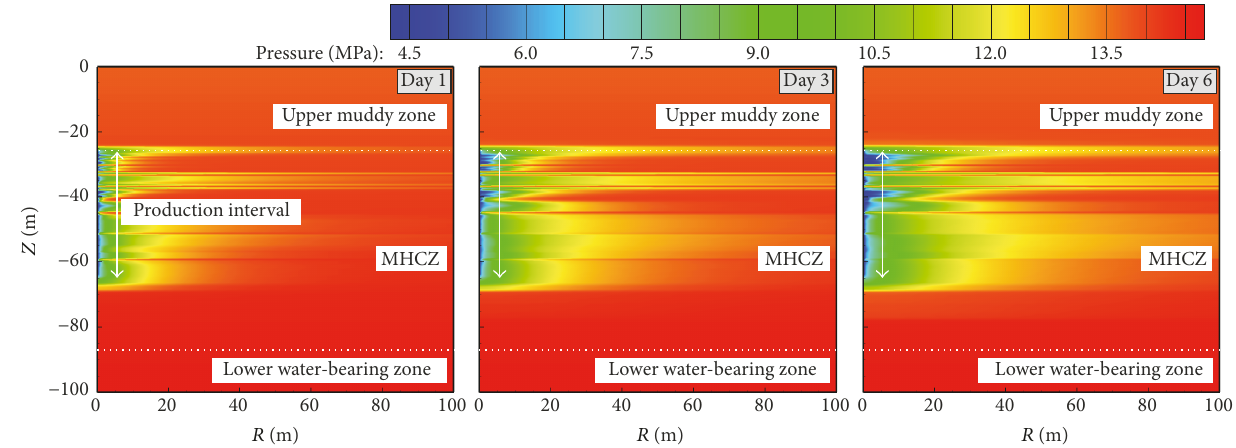
Figure 12: Evolution of spatial distribution of pressures in the hydrate reservoir at the AT1 site.